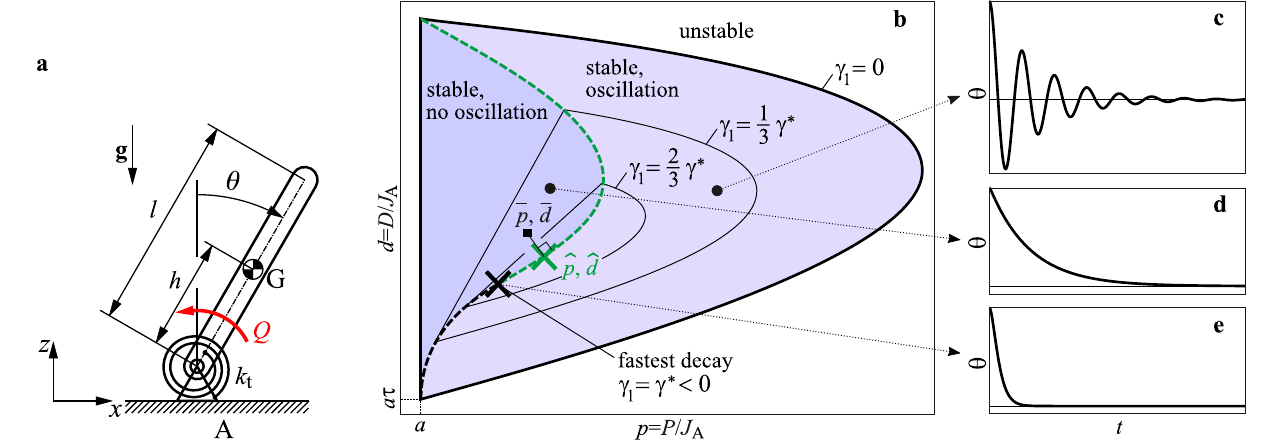
Figure 1. Main concept: dynamic behaviour of balancing by delayed feedback. ( a ) Inverted pendulum model for human standing balance. ( b ) Stability diagram for delayed PD feedback Q ( t ) = P θ( t − τ) + D ˙ θ( t − τ) . Light and dark grey shading indicates oscillatory (spiral type) and nonoscillatory (node type) stable responses, respectively. The two types of responses are separated by the node-spiral separation line indicated by (black- green) dashed line. Contour lines γ 1 = const are associated with different settling time of the response. Black × marker shows the parameter point ( p ∗ , d ∗ ) associated with fastest settling time. Green marker shows